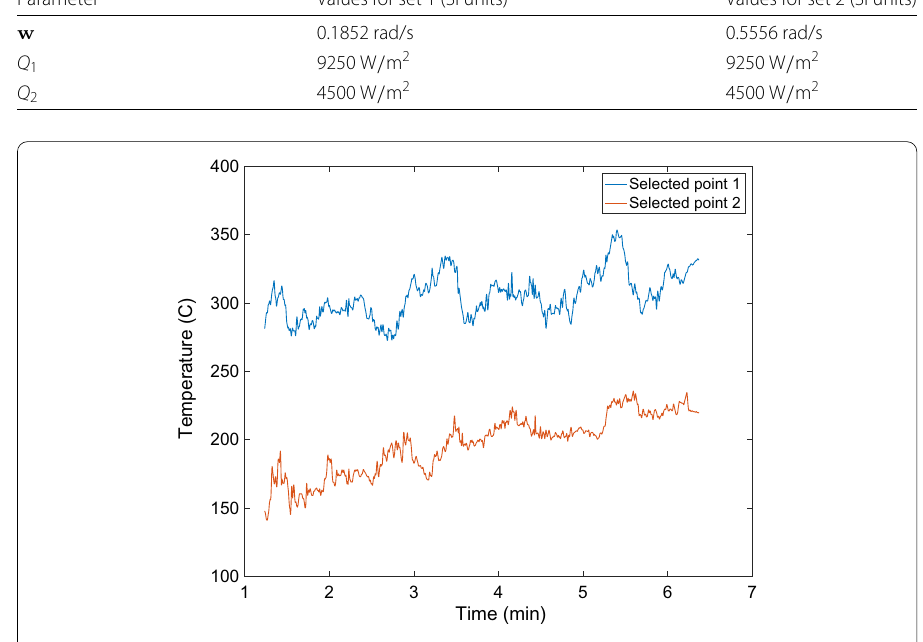
Fig. 3 The measurement data performed by thermal camera 1 at control points 1 and 2